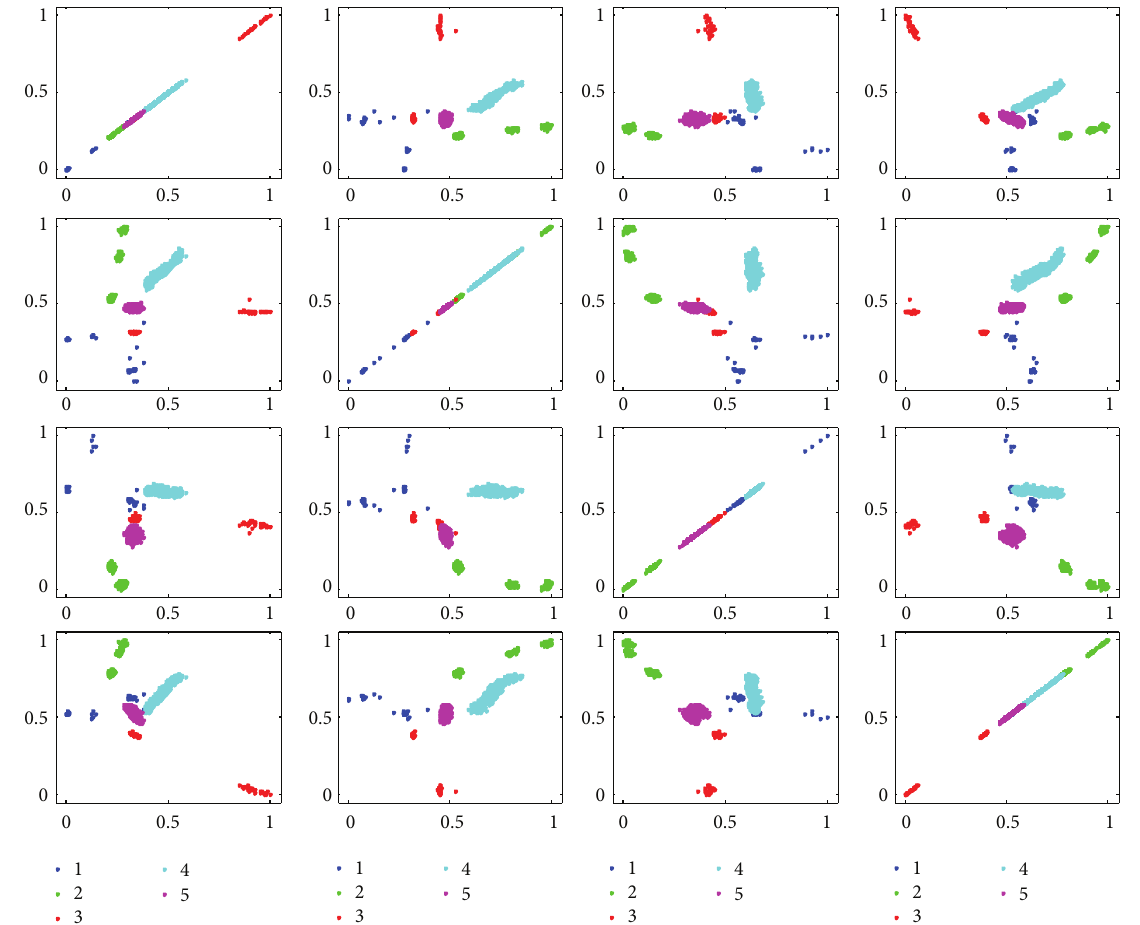
Figure 14: Scatter plots in 2D space expended with feature pairs selected by fuzzy